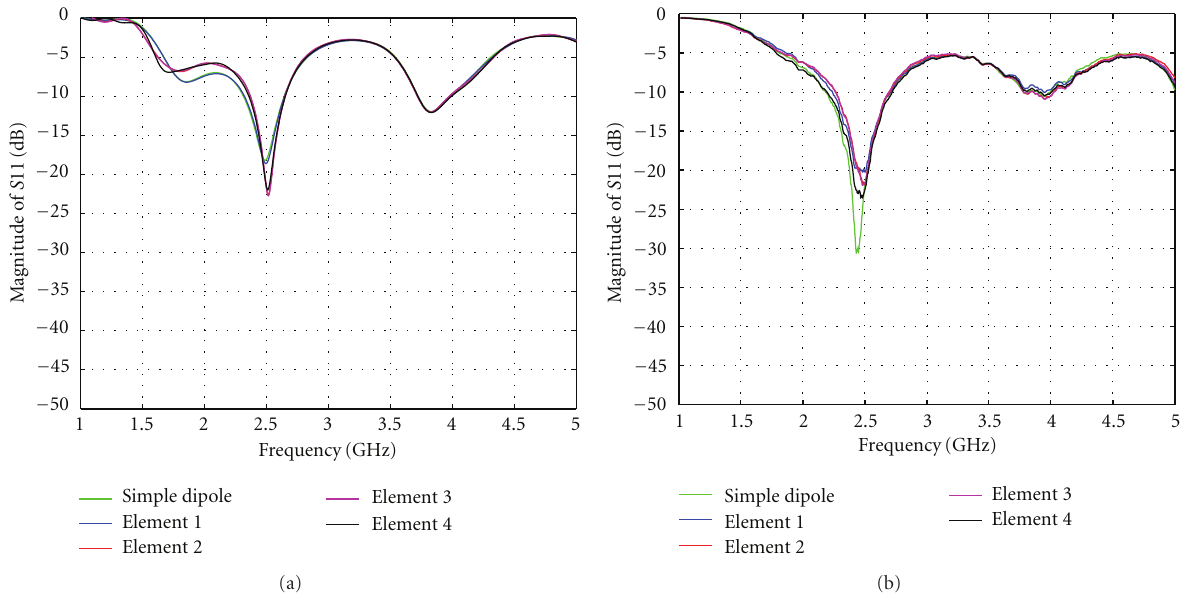
Figure 21: Magnitude of S 11 parameter in single dipole and elements on ULA array structures with wooden base: (a) simulated and (b)